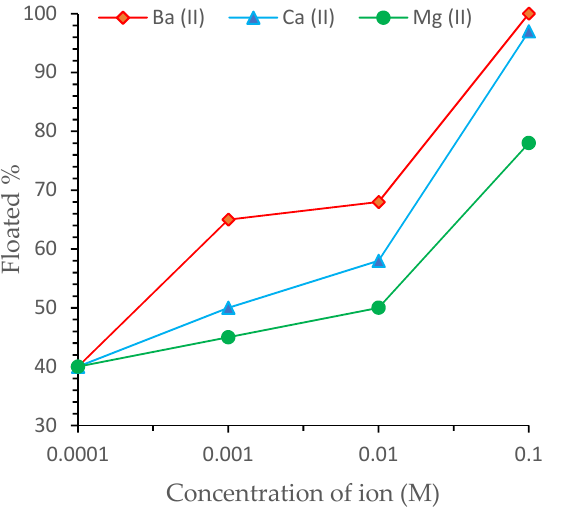
Figure 6. Effect of multivalent ion concentration on the activation of colemanite at pH 9.3 ± 0.1 [11].